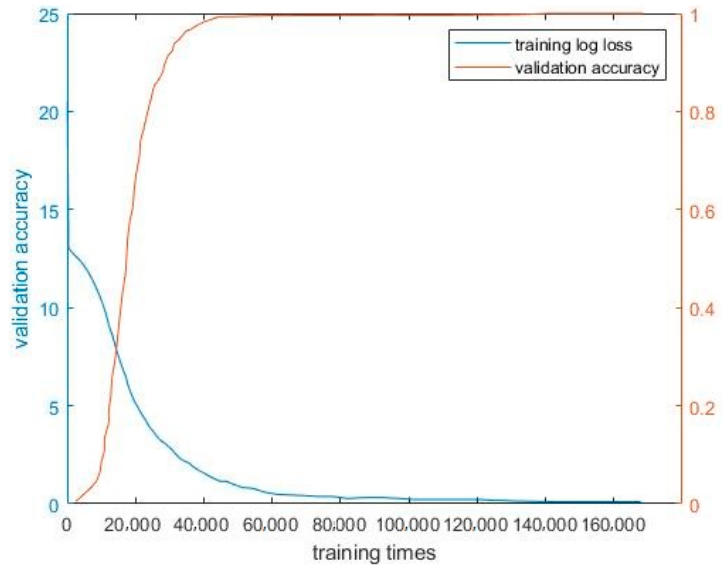
Figure 15. Loss function and recognition accuracy with respect to training time.